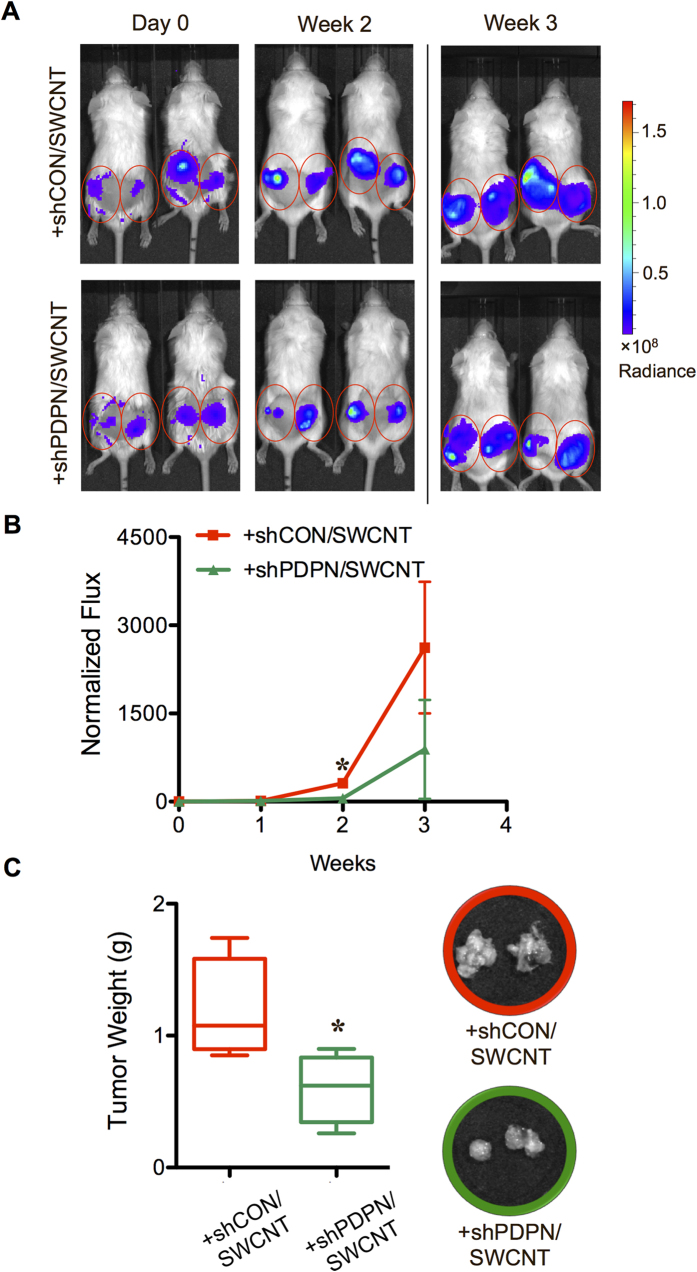
Podoplanin is required for the tumor promoting effect of carbon nanotube-induced cancer-associated fibroblasts.(A) Carbon nanotube-induced cancer-associated shCON fibroblast-like cells (shCON/SWCNT) or carbon nanotube-treated shPDPN fibroblast-like cells (shPDPN/SWCNT) at the dose of 6 × 105 cells were co-injected with luciferase-labeled H460 cells at the dose of 3 × 105 cells (2:1 ratio) into the left and right flanks of NSG mice. Tumor formation was monitored weekly by IVIS bioluminescence imaging. IVIS images of mice at day 0 and week 2 and 3 are shown. (B) Normalization of tumor bioluminescence signals at various time points post-injection to their initial signals at day 0. (C) Subcutaneous tumors were dissected from mice bearing H460 and LF/SWCNT or LF/BSA, and were weighted at the end of experiments at 3 weeks post-injection. Data are mean ± SD (n = 4). *P < 0.05 vs H460 and shCON/SWCNT group.